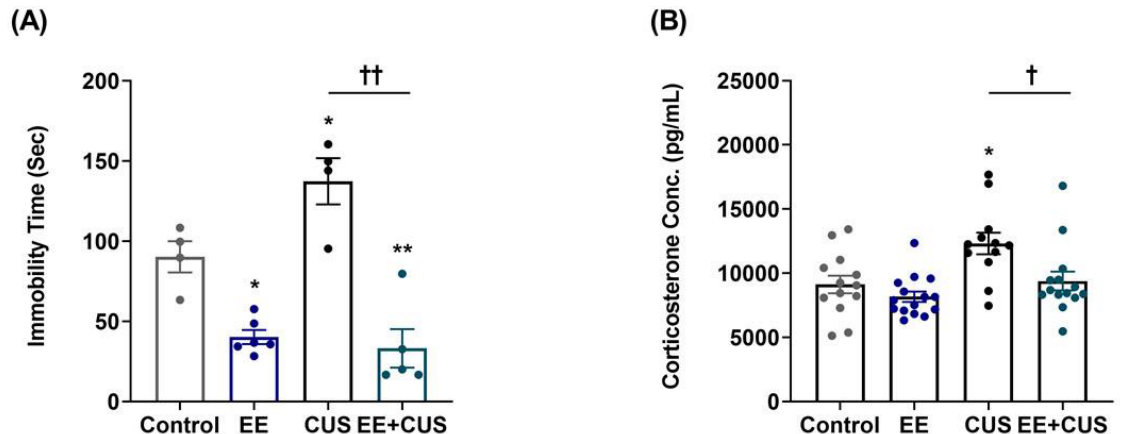
Figure 1. Experimental design. The mice pups were exposed to an enriched environment (EE) for 5 weeks during the post-weaning period. When the pups became adults (8 weeks of age), they were subjected to chronic unpredictable stress (CUS) for 4 weeks. Twenty-four hours after the last CUS protocol, the mice were exposed to the forced swimming test (FST). The mice were sacrificed immediately after FST.